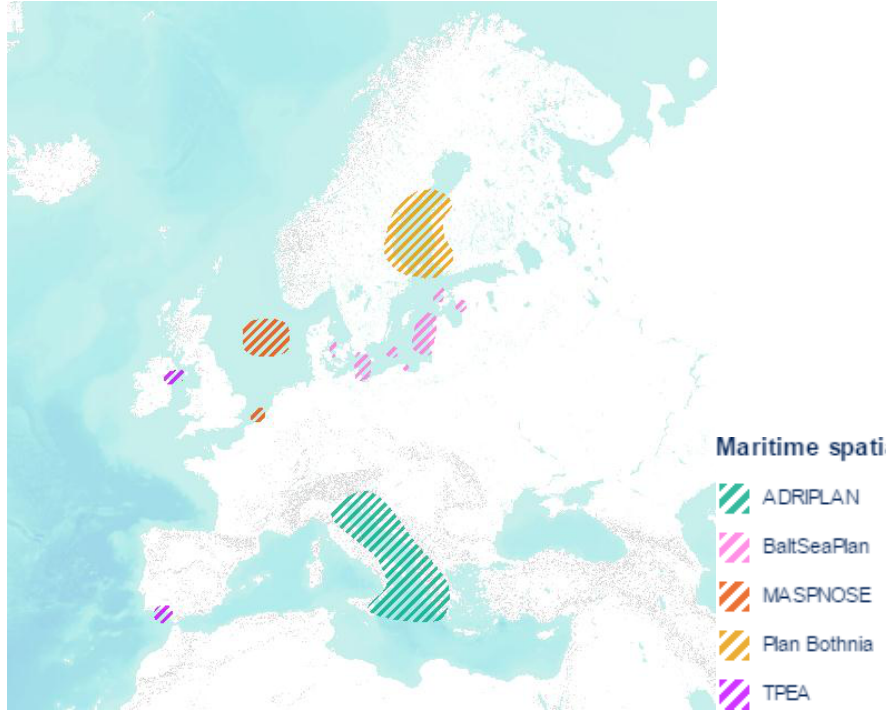
Figure 3. Maritime spatial planning in Europe. Source: [43]